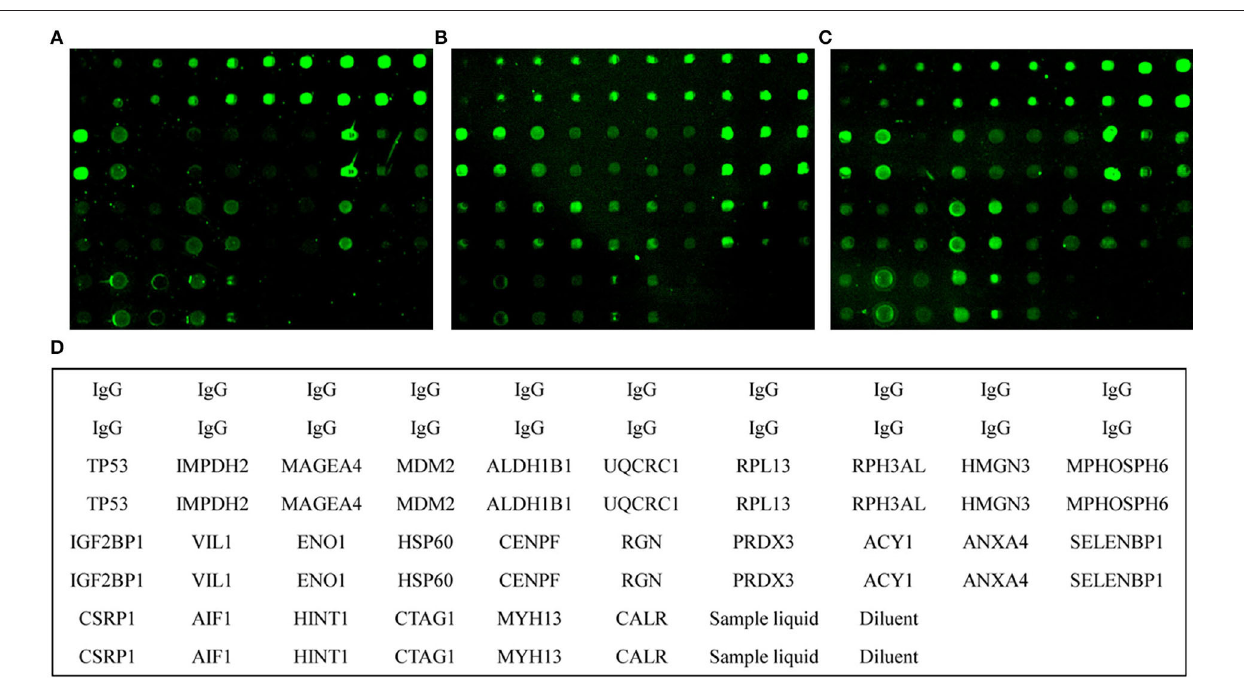
FIGURE 1 | Microarray analysis of serum samples. Individual arrays were reacted with healthy control (A) , advanced adenoma (B) , and colorectal cancer (C) samples. (D) , Schematic diagram of individual proteins in the protein microarray matrix. Sample liquid, phosphate-buffered saline (PBS) with 0.02% SDS and 1% glycerol. Diluent,